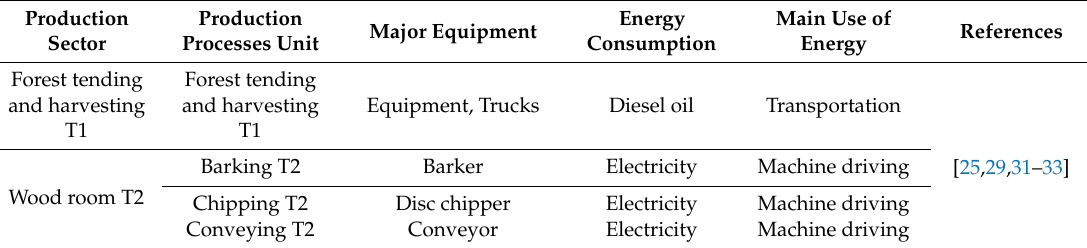
Figure 1. Production processes units and energy supplies. Table 1. Main production units and key equipment.